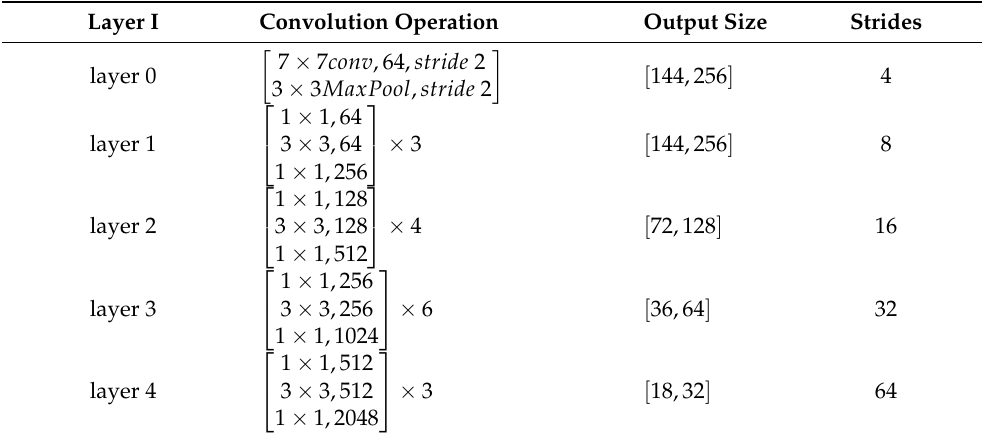
Table 1. The structure and output sizes of ResNet50